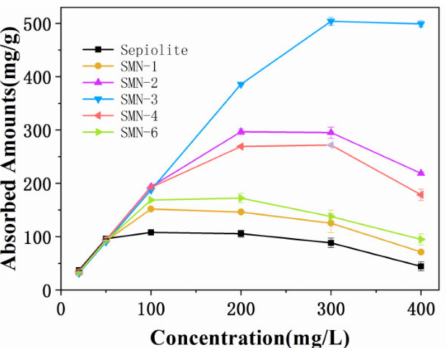
Figure 1. Effect of initial concentration on Pb(II) adsorption (dosage of SMN-x was 25.00 mg, adsorp- tion time was 12 h, pH was 5 and temperature was 25 ◦